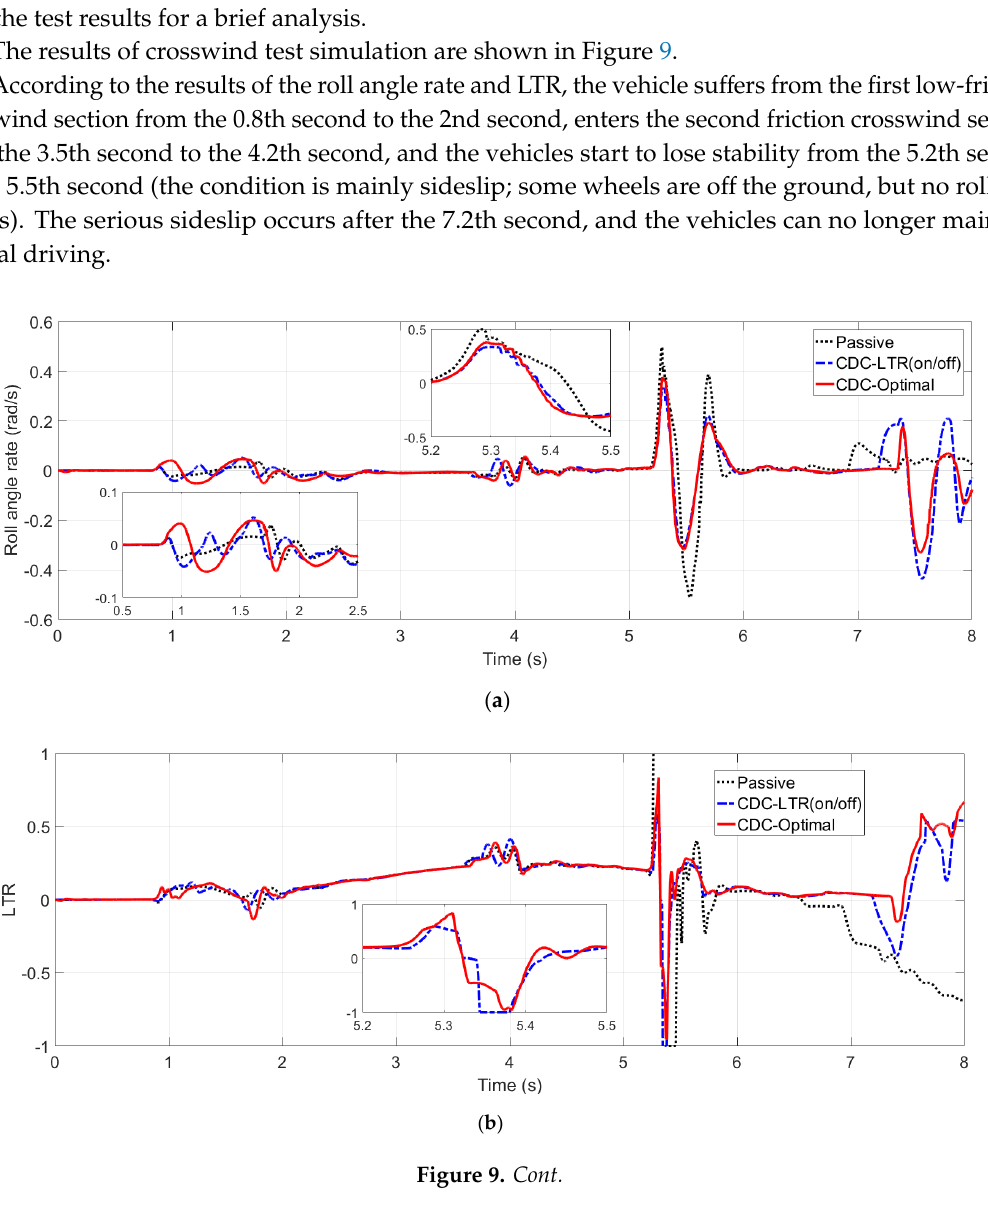
Table 5. Main parameters of crosswind test.